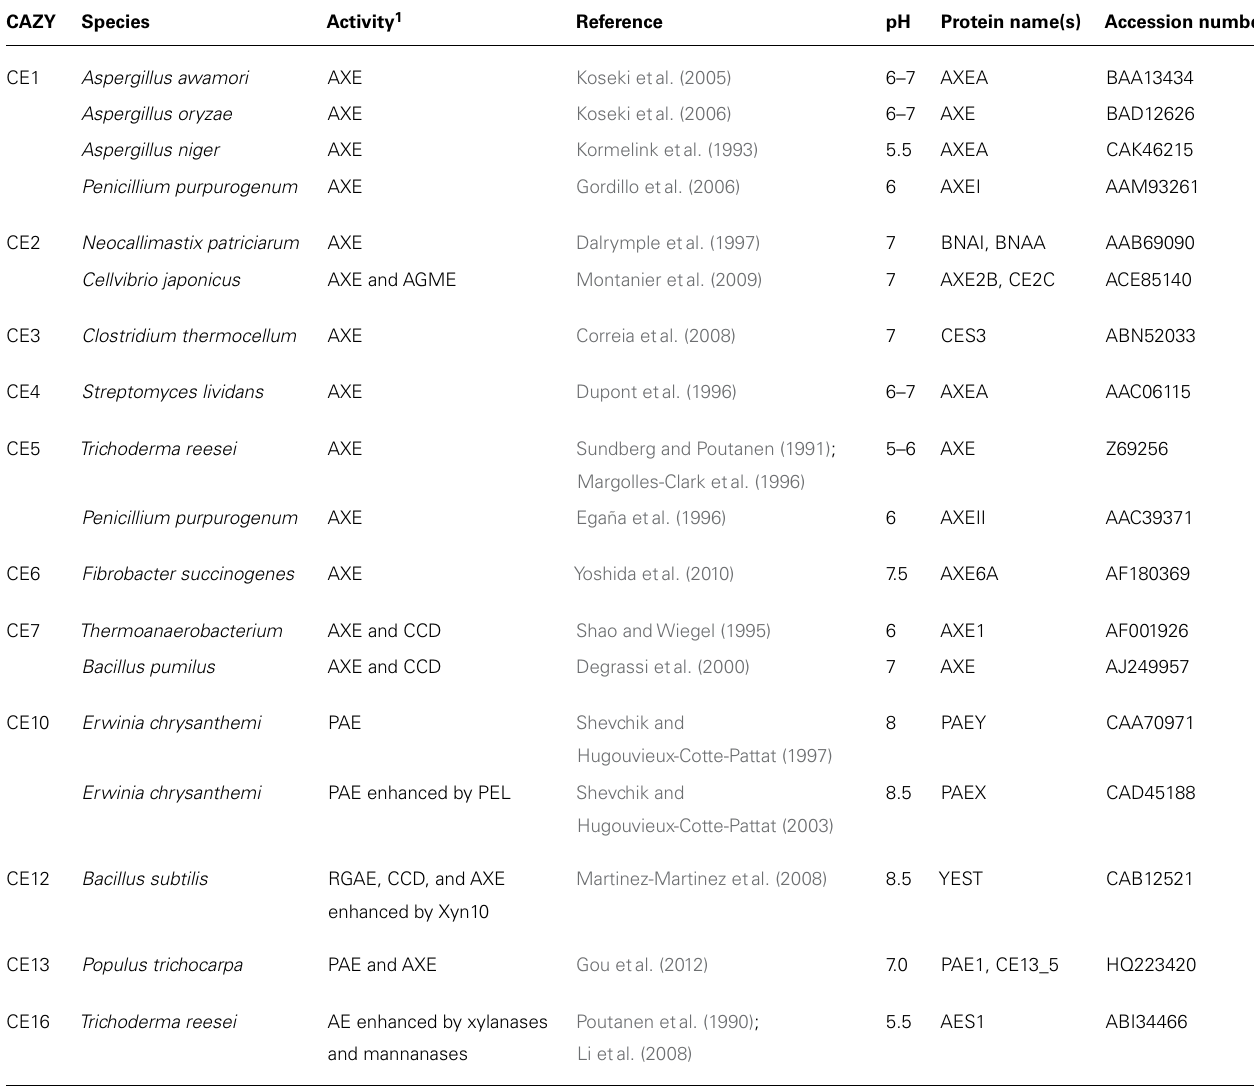
Table 2 | Examples of enzymes deacetylating plant cell wall poly and oligosaccharides.